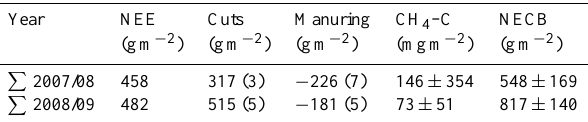
Table 3. Composition of the NECB at the intensive grassland site of the Ahlen-Falkenberger peat bog. The number of management interventions is shown in parentheses. Note that cuts are defined as carbon loss (positive sign) while manuring is defined as carbon gain (negative sign). Small differences in the sums are due to rounding errors.